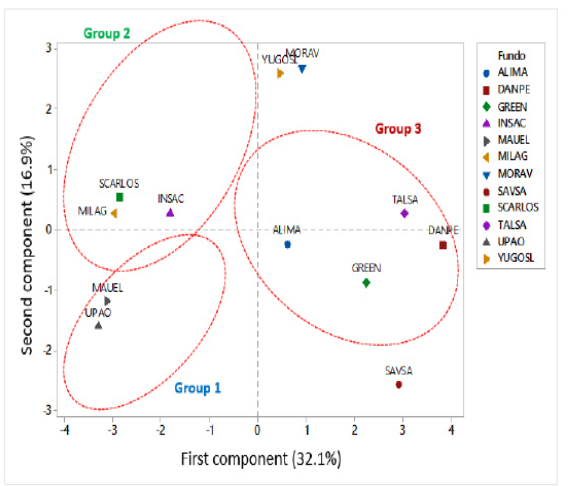
Figure 6. Variables analysed by main principal component analysis of the avocado